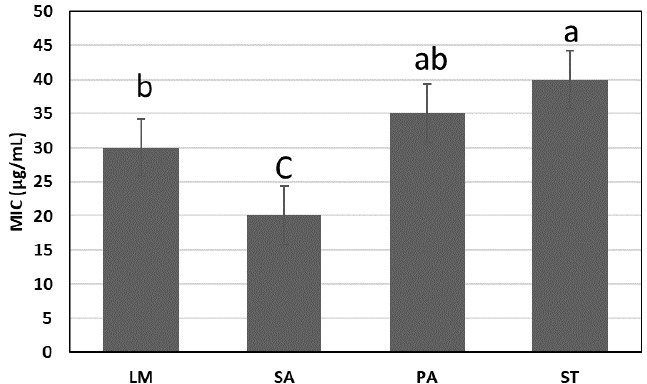
Figure 10. The minimum inhibitory concentration of LPE against tested bacteria. Lowercase letters above the columns indicate significant differences at a 5% probability level.